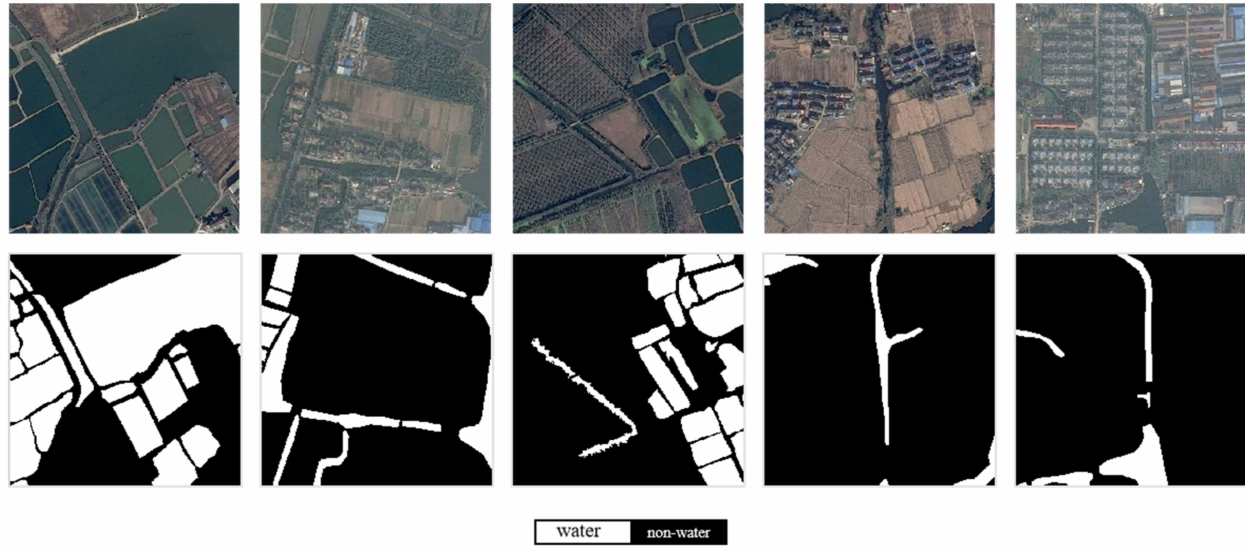
Figure 5. Raw images and ground truth masks from the 2020 Gaofen Challenge water-body segmentation dataset.